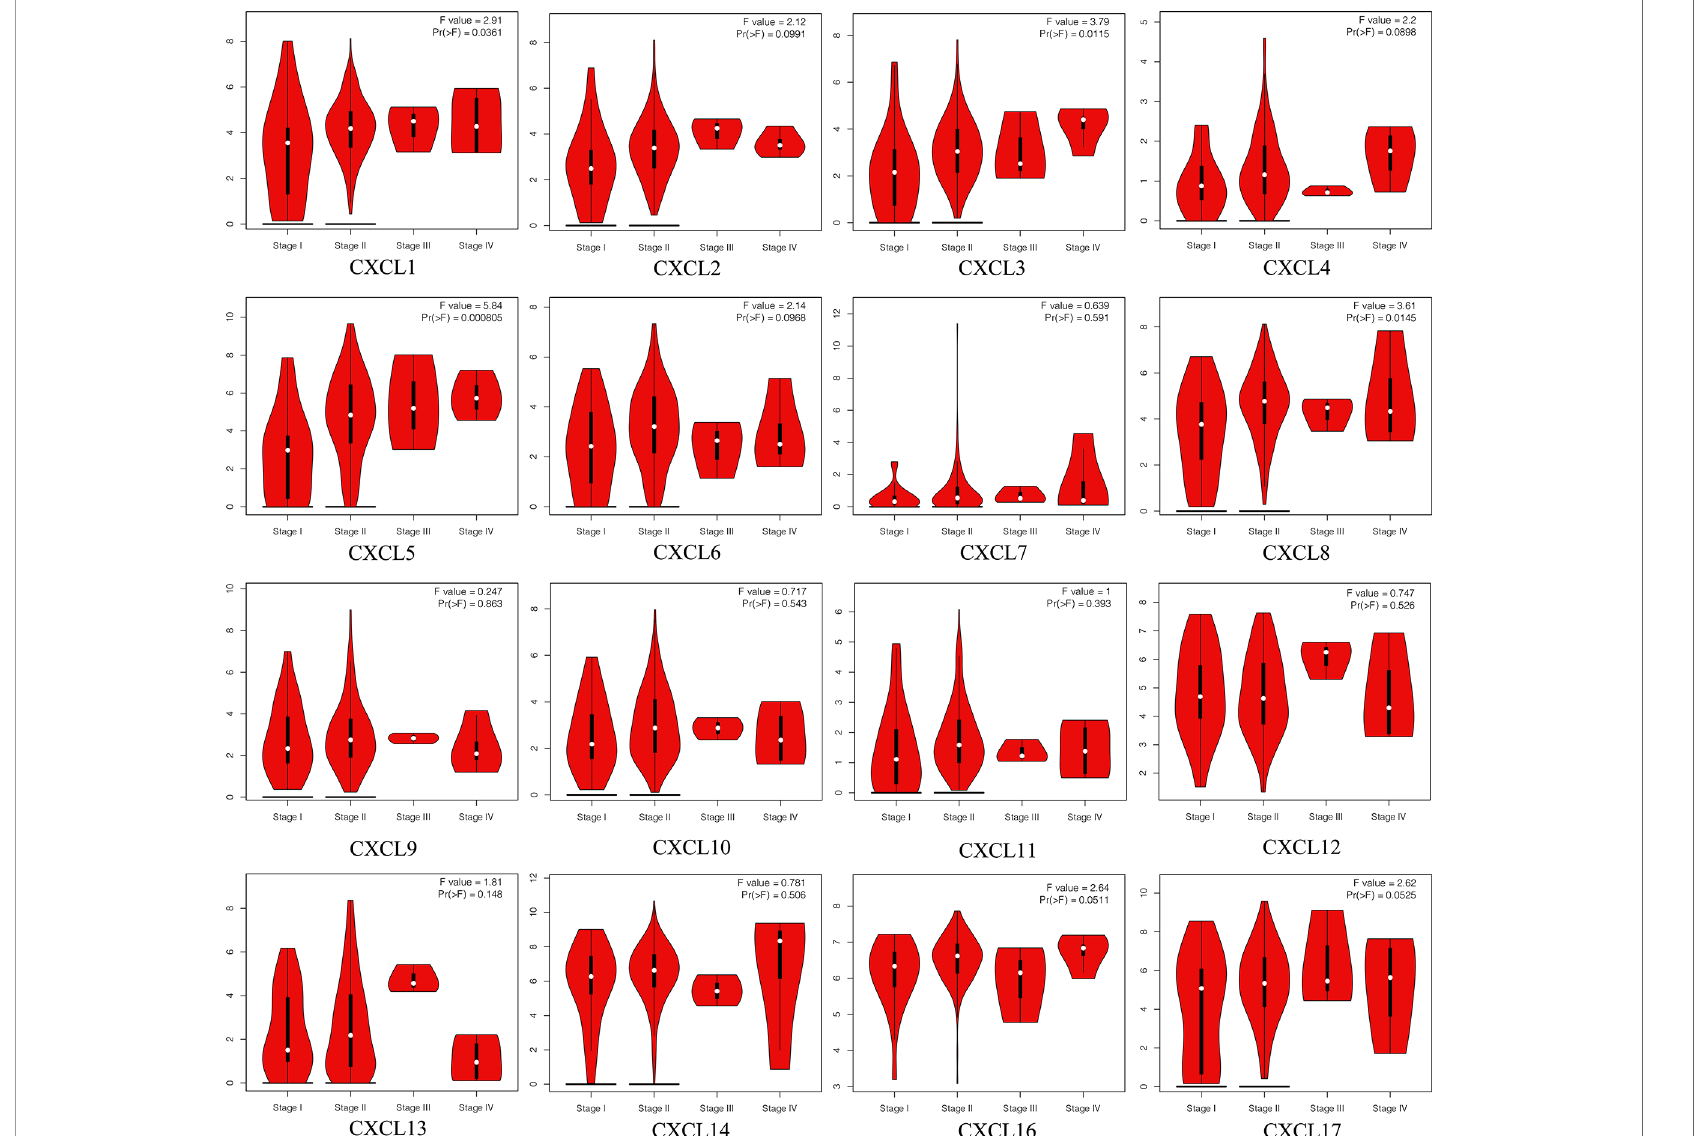
FIGURE 7 | The correlation between each CXC chemokine expression and clinicopathological stages in patients with PAAD